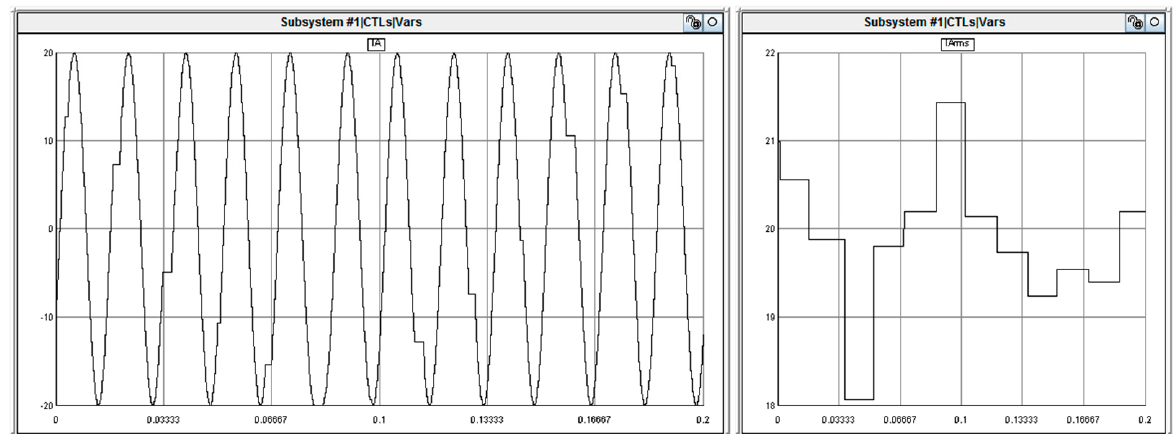
Figure 5. Incoming SV messages (phase ‐ A current).